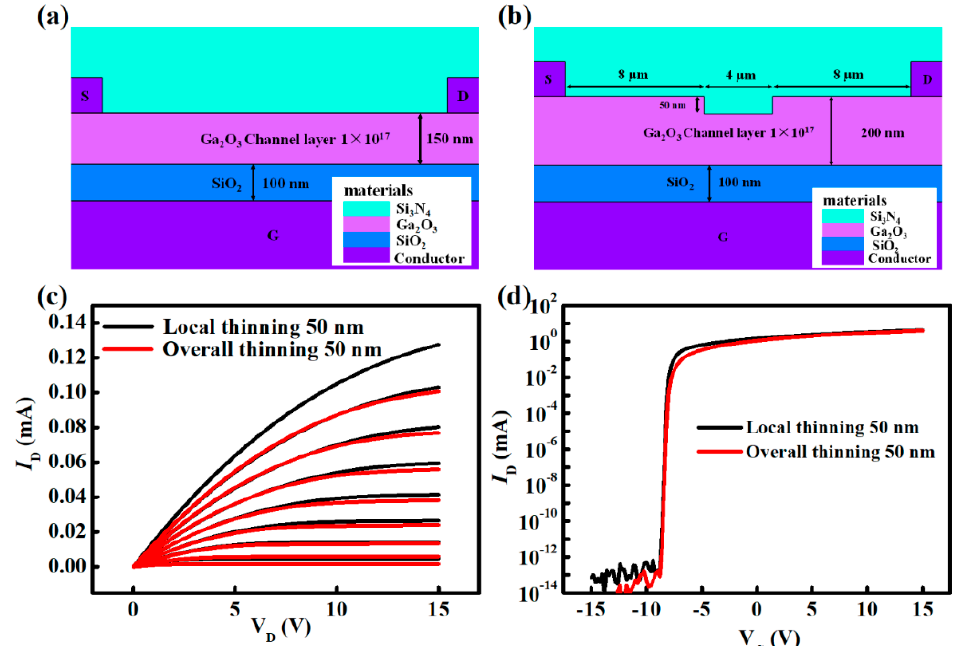
Figure 2. Schematic diagram of the simulation of the overall thinning of 50 nm ( a ) and the local thinning of 50 nm ( b ), output characteristic curves ( c ) and transfer characteristic curves ( d ) of overall thinning 50 nm and local thinning 50 nm.